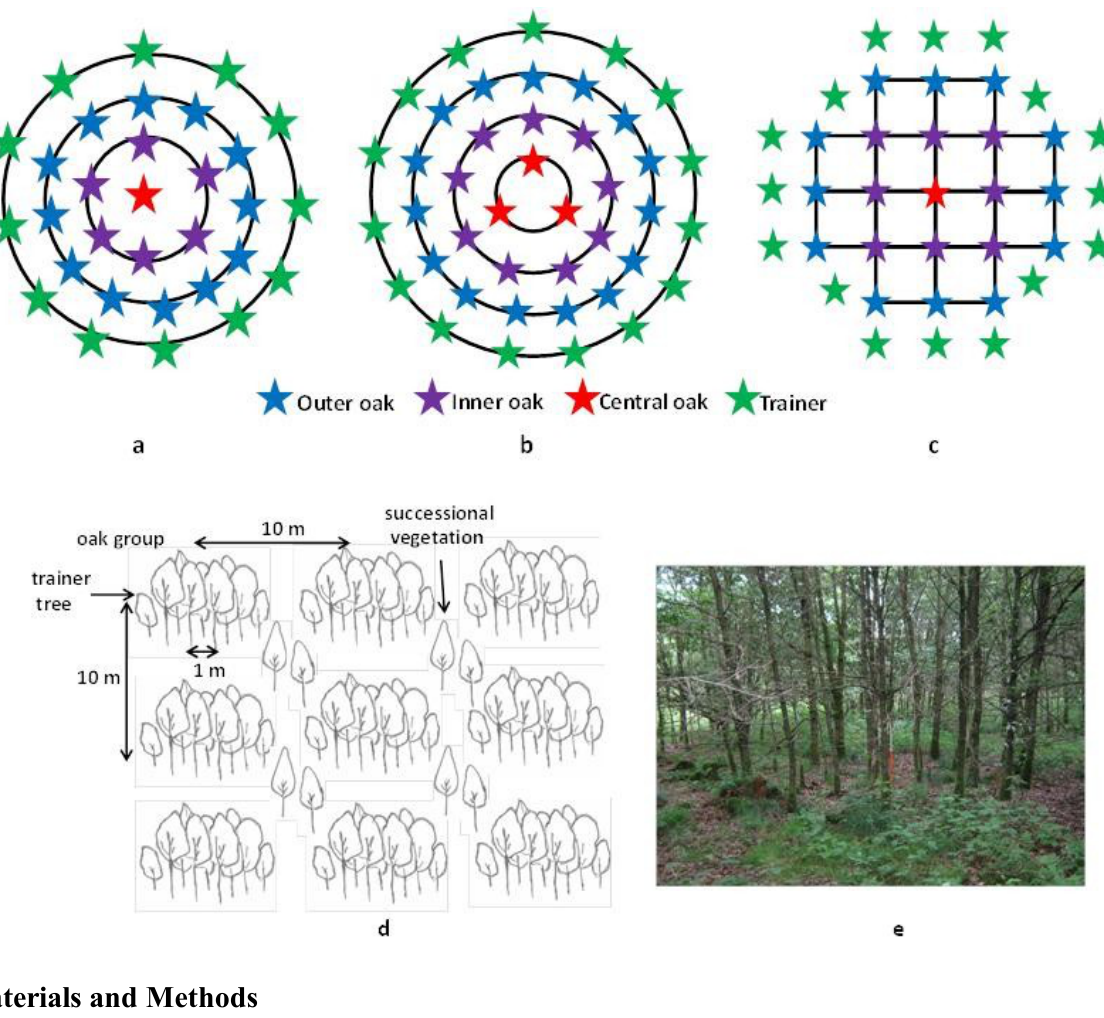
Figure 2. ( a – c ) Gockel’s (1994) group planting design with 3 variants; ( d ) 10 × 10